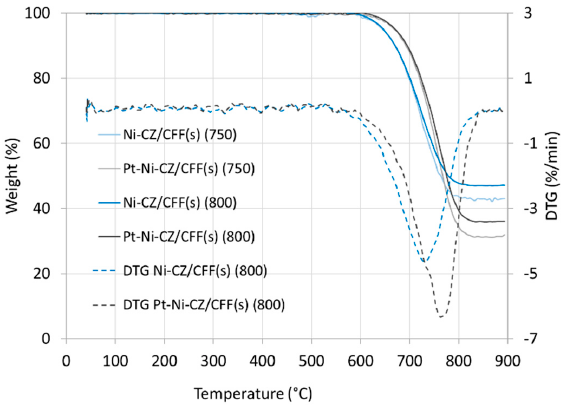
Figure 15. TGA and DTG for Ni-CZ/CFF and Pt-Ni-CZ/CFF catalysts spent in 8 h tests of DRM at 750 and 800